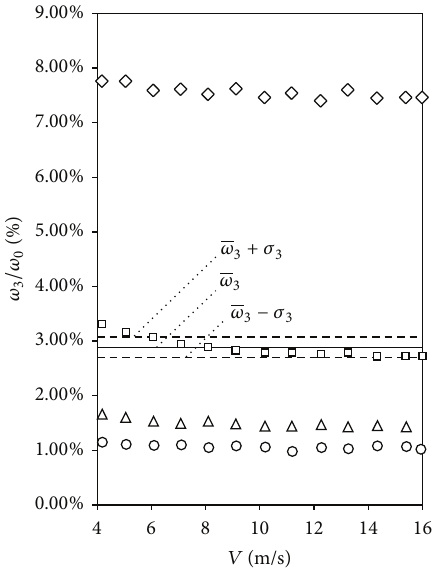
Figure 5: Non-dimensional harmonic term, 𝜔 3 /𝜔 0 , calculated at every point of the calibrations performed on the Climatronics 100075anemometerequippedwithc-25/60(circles),h-09/60(trian- gles), h-19/60 (squares), and h-24/60 (rhombi) rotors. The average value line, 𝜔 3 , together with the standard deviation limits, ±𝜎 3 , corresponding to the h-19/60 rotor values has been also included in the